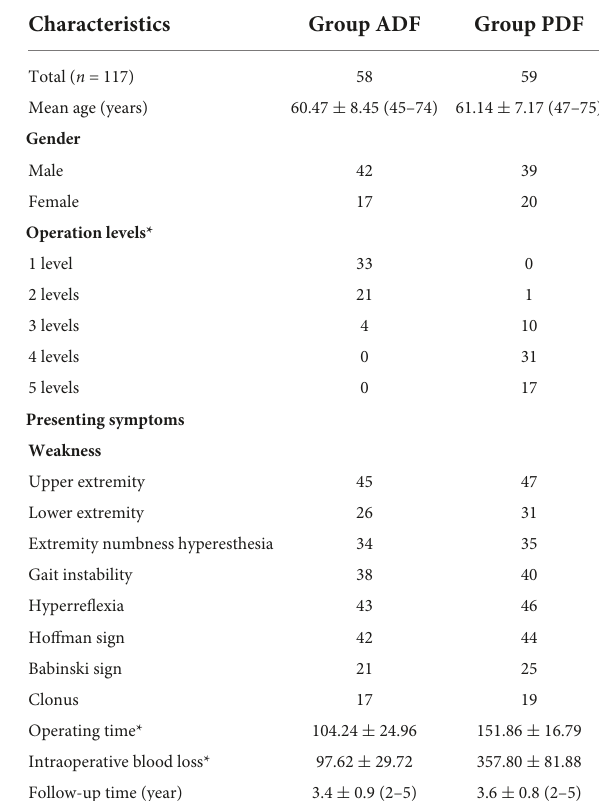
TABLE 1 Patient